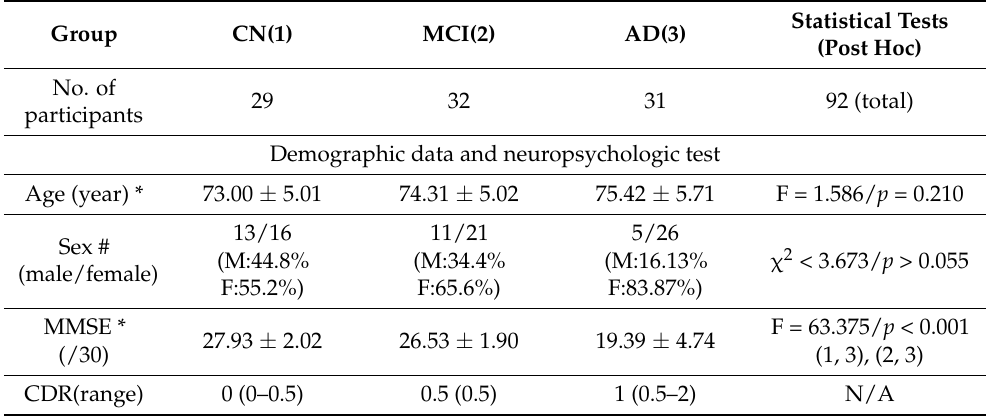
Table 1. Summary of the statistical results of the demographic